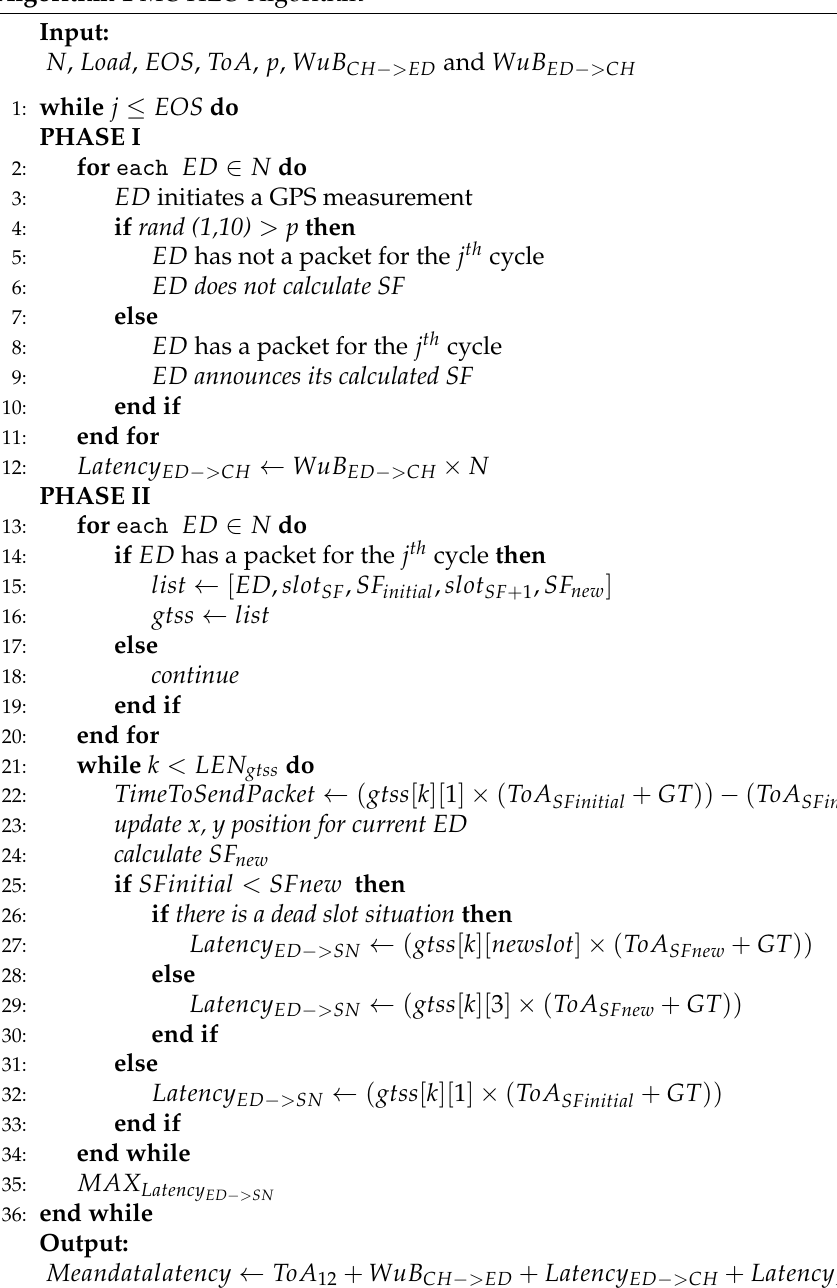
Algorithm 1 MOTILO